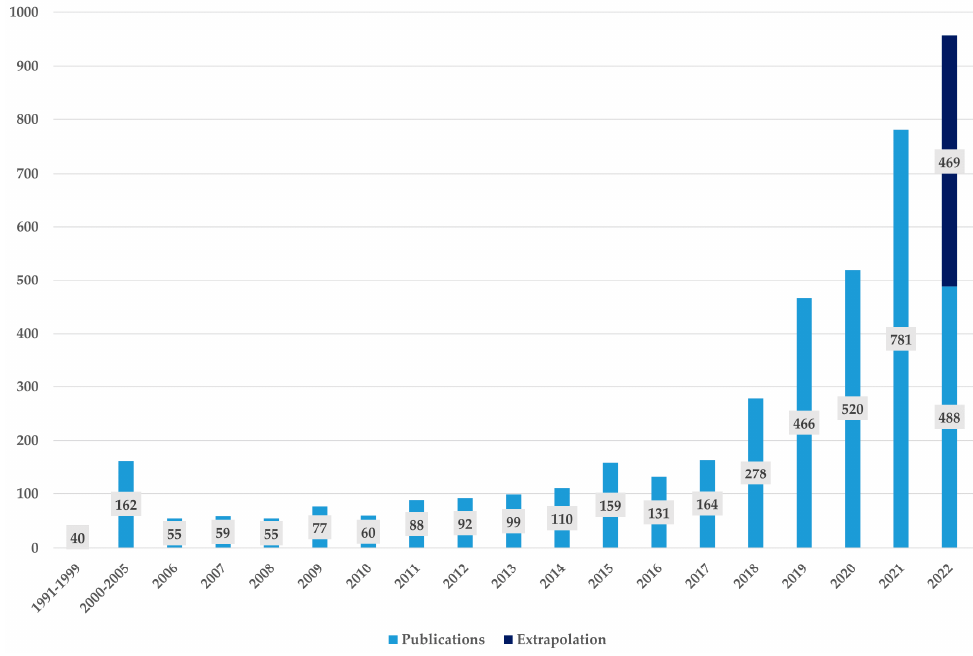
Figure 2. Number of publications per